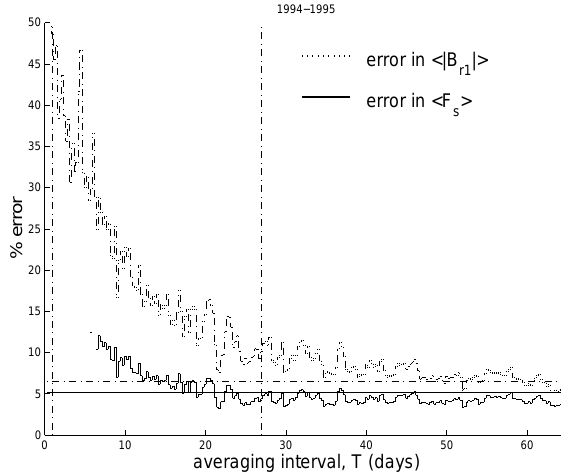
Fig. 8. Variations with the averaging timescale, T . (Dashed line) the percentage deviation ε r of the normalised radial field magnitude, < | B ru | (r u /r 1 ) 2 > at time t u from the value observed near Earth at time (t u − L) , < | B r 1 | > . (Solid line) the inferred uncertainty ε F in the open solar flux estimate deduced from near-Earth IMF ob- = 2 πr 12 | B r | . The vertical dashed line marks servations [ F s ] 1 IMF the mean solar rotation period (in the Earth’s frame) of 27 days. The horizontal dashed line is the value of { < | B ru | (r u /r 1 ) 2 > − < | B r 1 | > } for the full duration of the perihelion pass, the horizontal solid line is the inferred error ε Fs for the whole pass.